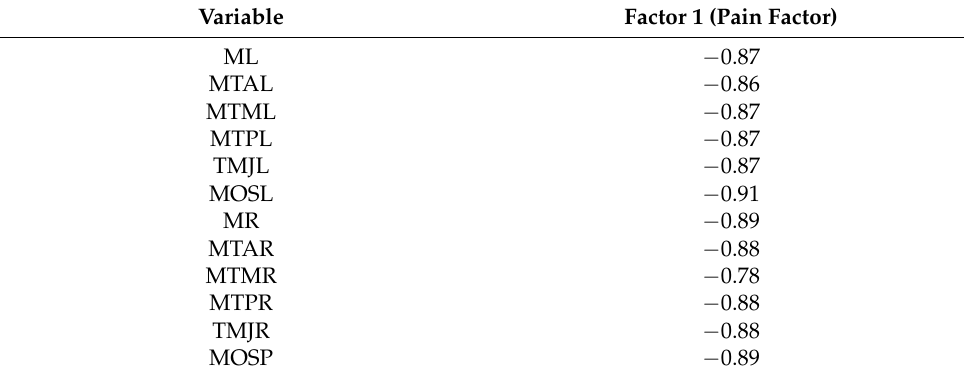
Table 2. Loadings of variables used to component interpretation.